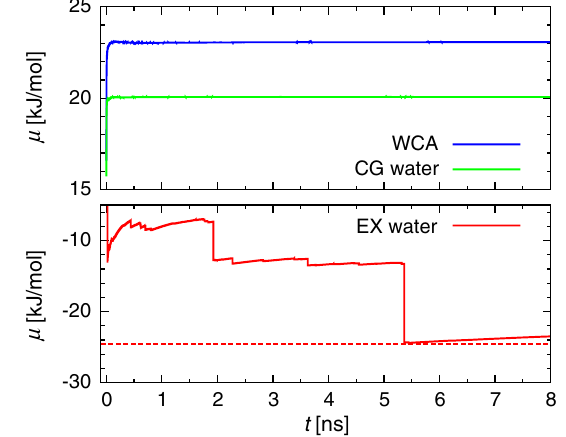
FIG. 8. The chemical potential calculated by the IPM. The top panel shows the case of CG water and the WCA liquid, while the bottom panel shows the case of an EX simulation. The horizontal dashed line in the bottom panel is used to guide the eyes and represents the ideal target. The plot shows the result that, for EX water, the IPM procedure does not converge within 8 ns; in fact, the convergence of the chemical potential means that the in- sertion of the molecule is properly done, and a subsequent part of the trajectory (with the associated IPM) can be used for a ‘‘statistical’’ average in a grand-canonical framework.